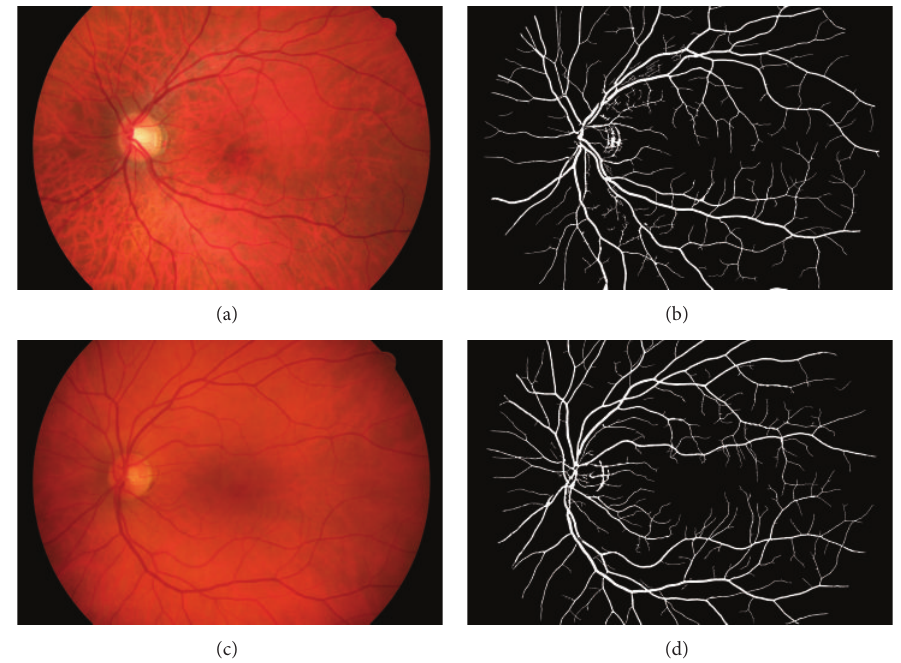
Figure 7: Example segmentation results on high resolution images with different illumination and background